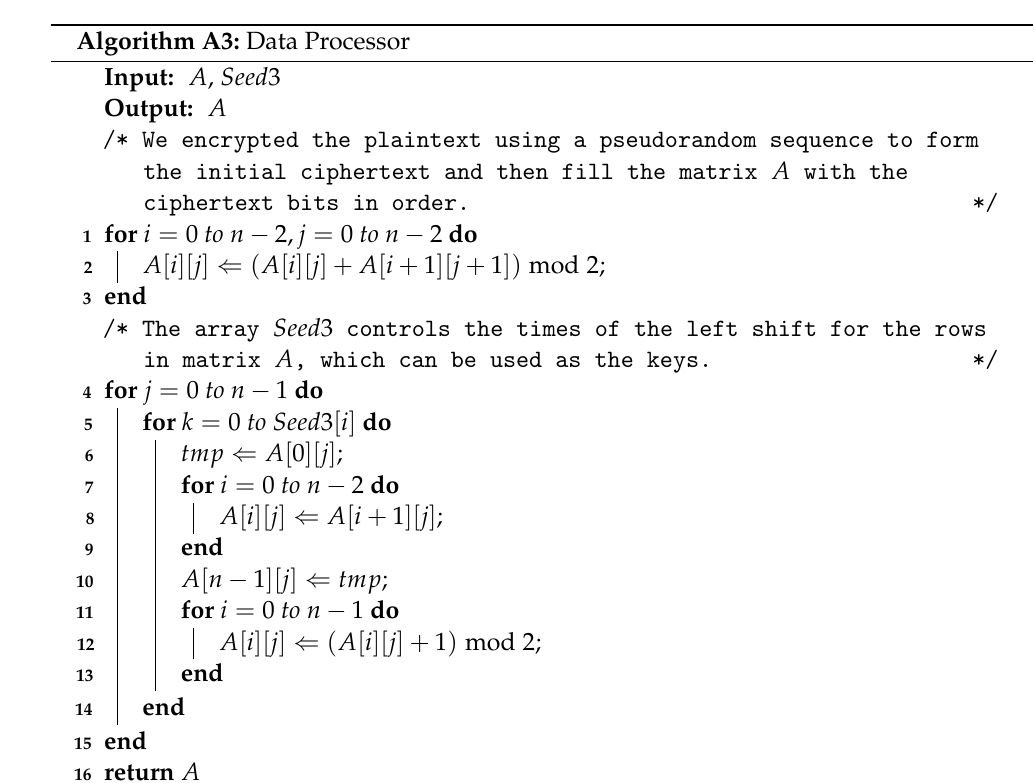
Algorithm A3: Data